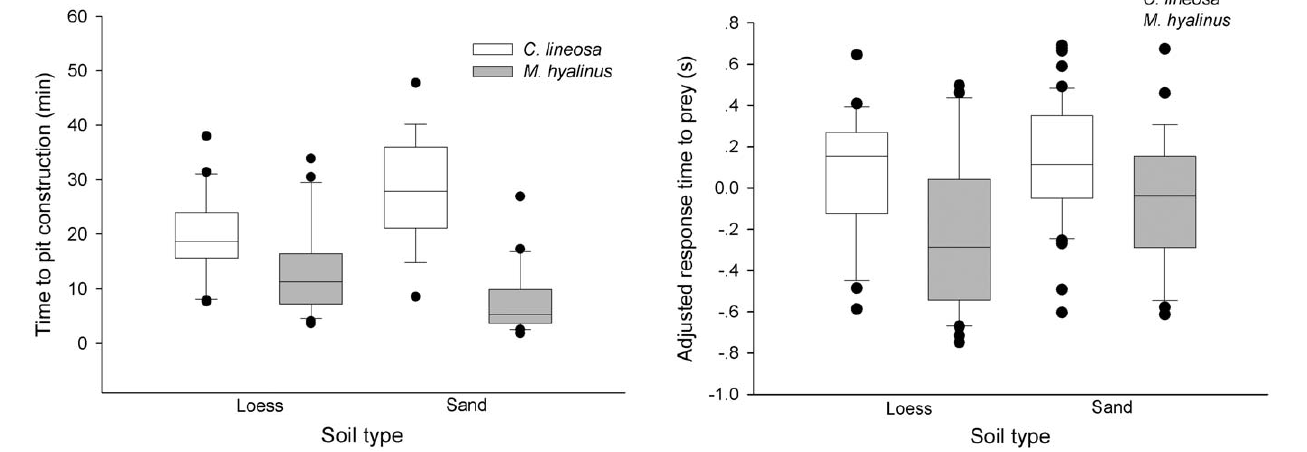
Figure 4. Response time of antlions to prey. M. hyalinus larvae responded to prey faster than C. lineosa larvae, irrespective of the soil type. Key: median (horizontal lines in boxes), inter-quartile range (boxes), 95th and 5th percentiles (vertical bars), outliers (black dots).